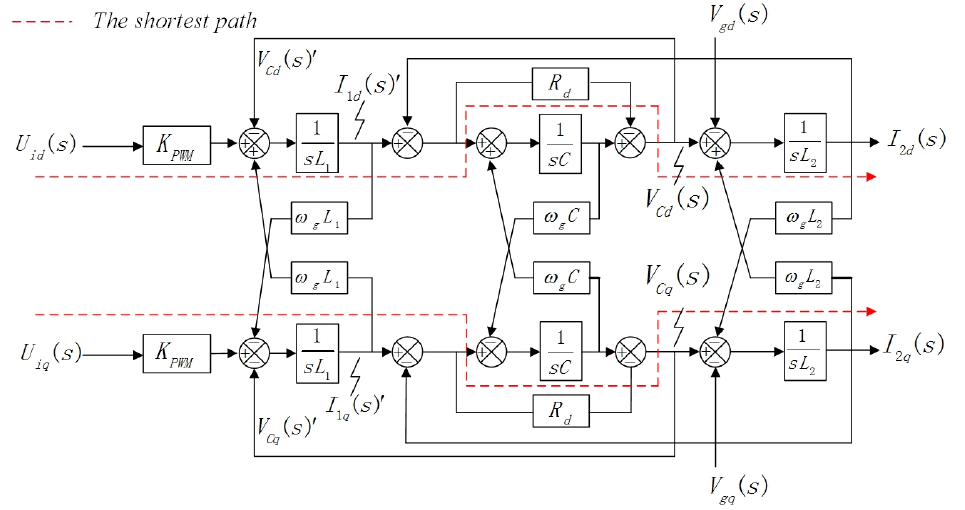
Figure 2. Block diagram of LCL-type filter with passive damping